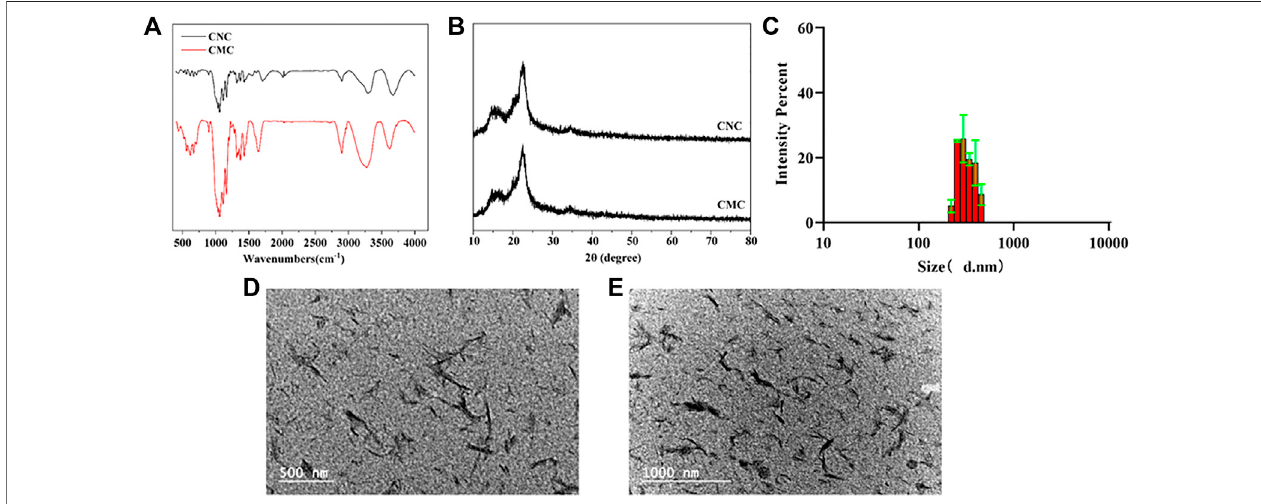
FIGURE1| Modi fi cationandcharacterizationoftheCNC: (A) FouriertransforminfraredspectraoftheCNCandCMC; (B) X-raydiffractionpatternsoftheCNCand CMC; (C) DLS image of the CNC; and (D,E) TEM images of the CNC at different magni fi cations. Data are shown as mean ± SE (* p < 0.05; ** p < 0.01).